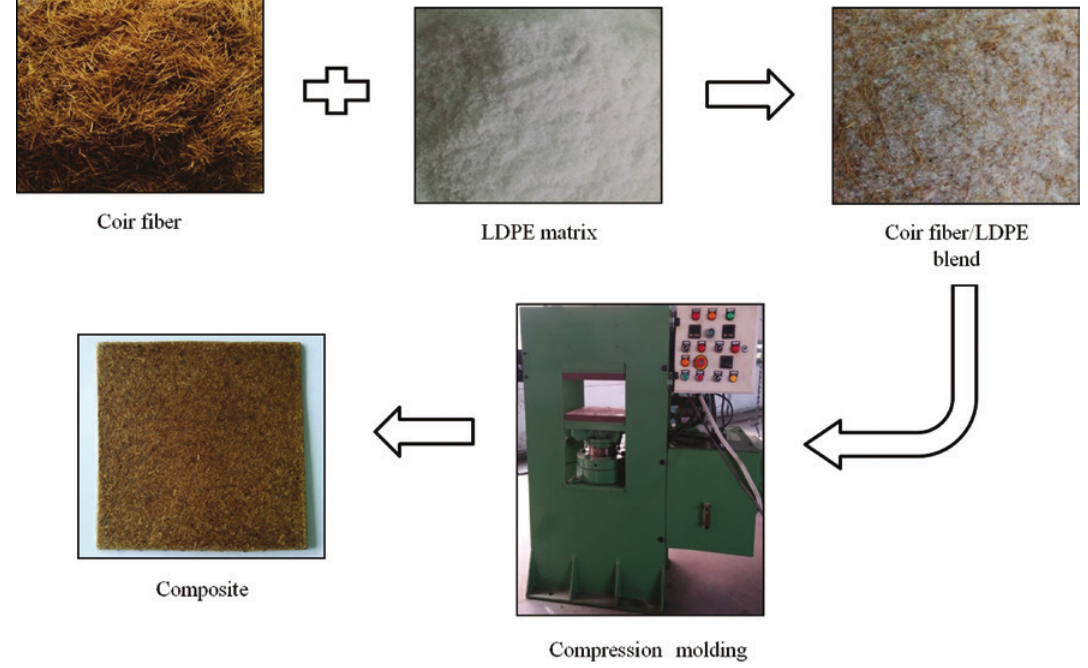
Figure 1: Schematic representation of the preparation of the CF/LDPE